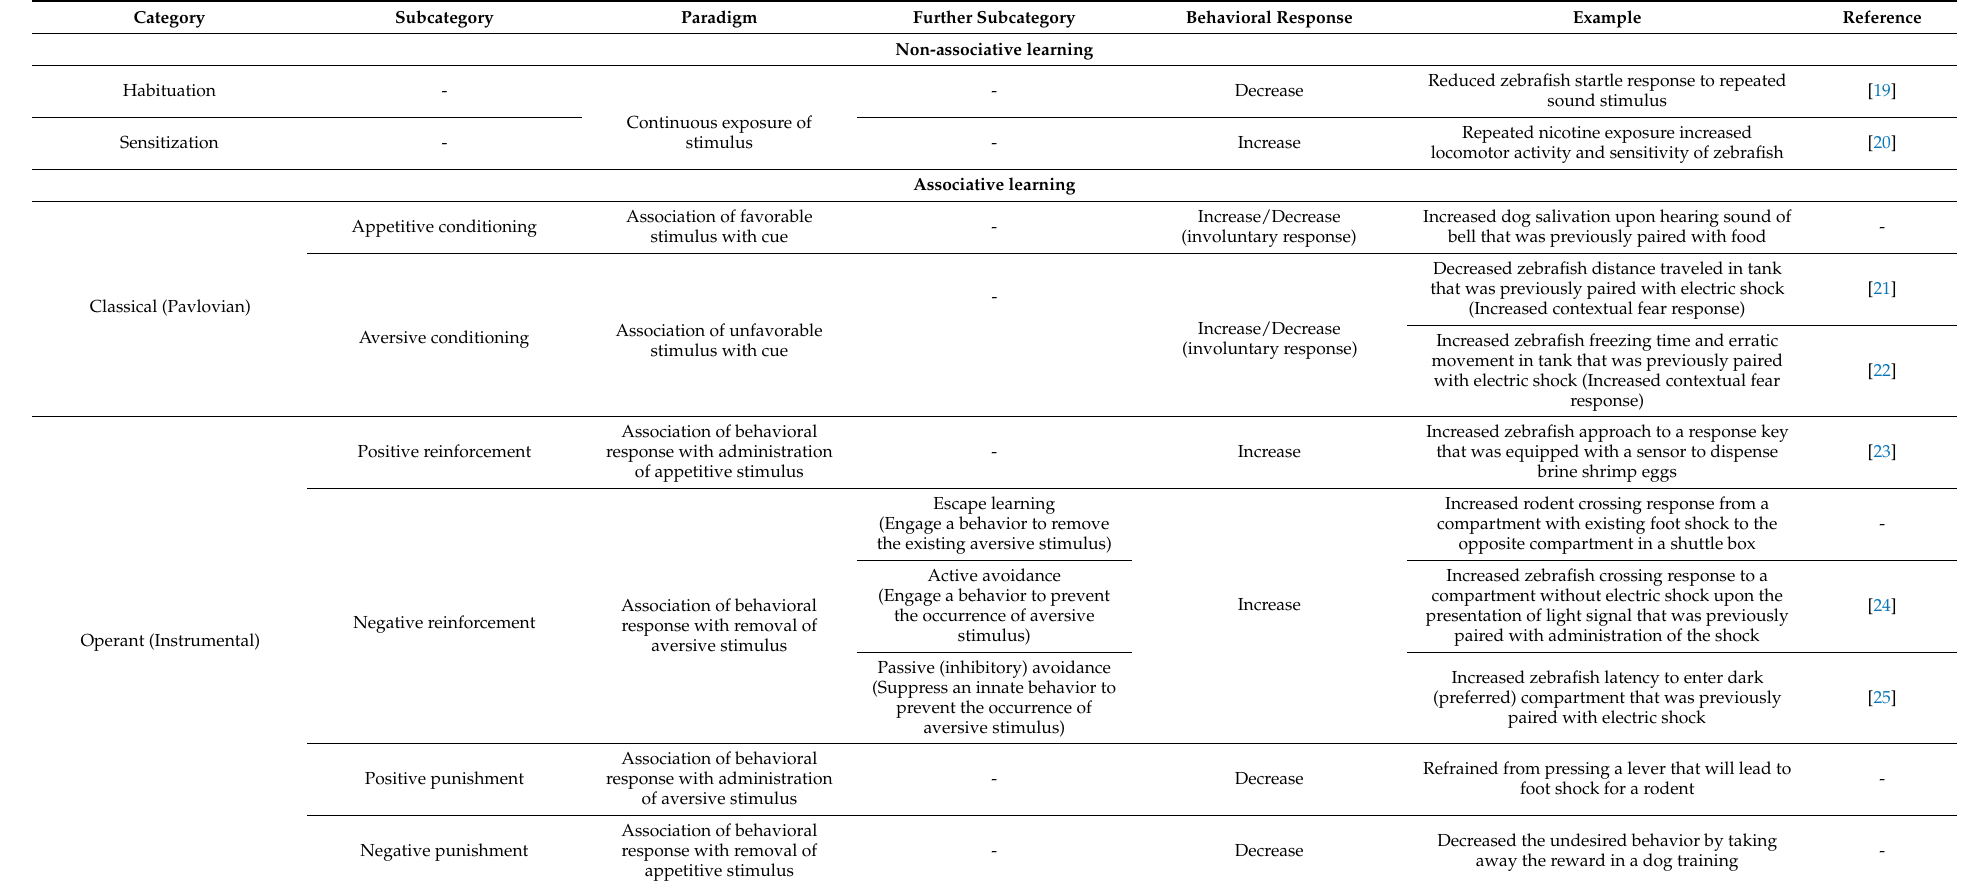
Table 1. Types of non-associative and associative